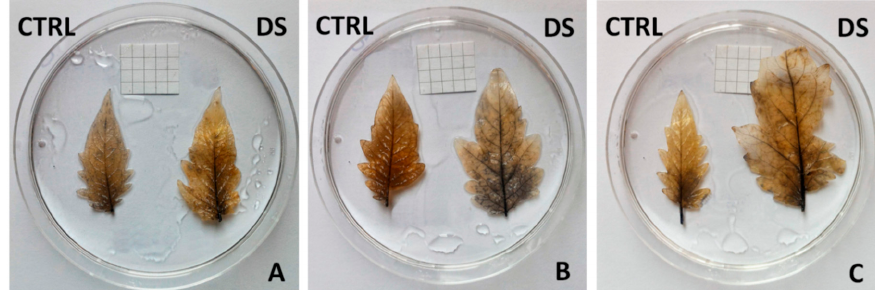
14 of 22 Figure 9 . Stomatal density in two local varieties (‘Fragola’ and ‘Pisanello’) and one commercial cultivar ‘Supersteak’ of tomato ( Solanum lycopersicum L.) subjected to drought stress (no water for 16 days) relative to the controls (regularly well-watered plants). Two-way factorial ANOVA followed by Tukey post-hoc test was used to determine the statistical significance of differences. Points with